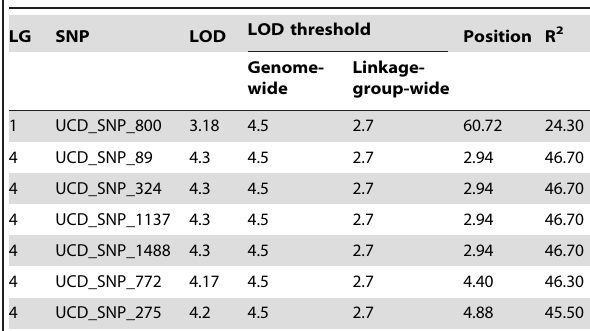
Table 2. Identification of QTLs controlling brown rot resistance with two years of data in the F1 population from ‘Dr. Davis’ x